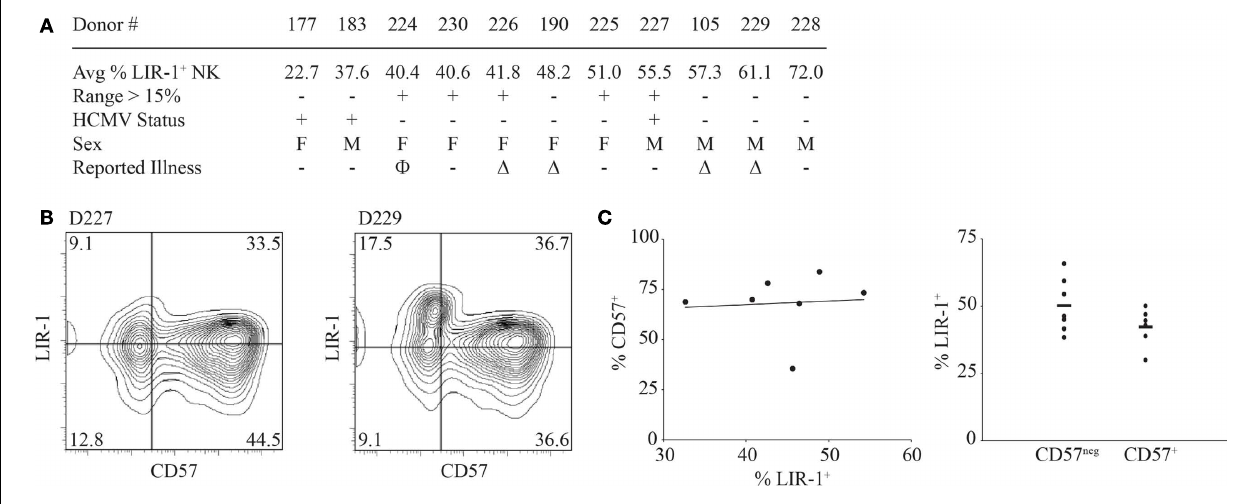
correlate with high CD57 staining. Ex vivo PBL were examined for the co-expression of LIR-1 and CD57 on NK cells as described in the Section “Materials and Methods.” Representative profiles from two donors are shown. (C) The frequency of CD57 is plotted against the frequency of LIR-1 examined on donor NK cells. Each point represents an individual donor (left panel).The proportion of LIR-1 positive cells on CD57 + and CD57 neg NK cells from the same donors is shown with the mean frequency indicated (right